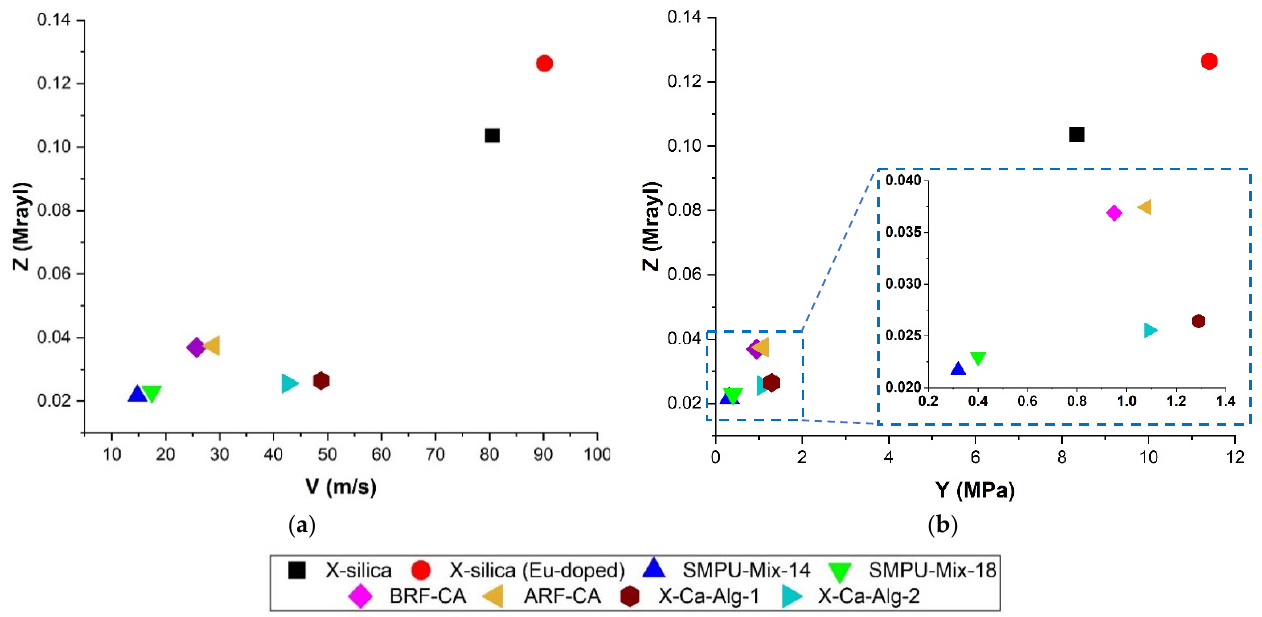
Figure 4. ( a ) Correlation between impedance values and sound speed for each type of aerogel used in this study. ( b ) Impedance as a function of Young’s modulus for all the aerogels used in the experiment. Both ( a , b ) represent data in an Aq environment.